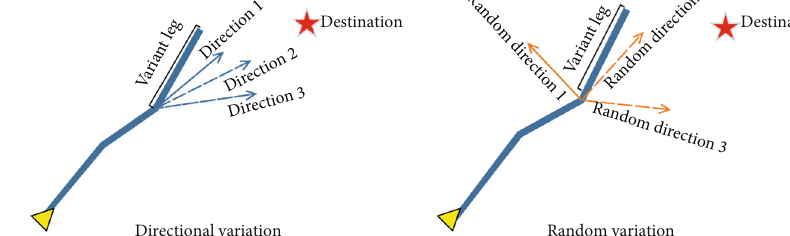
Figure 4: Variation strategy comparison chart.